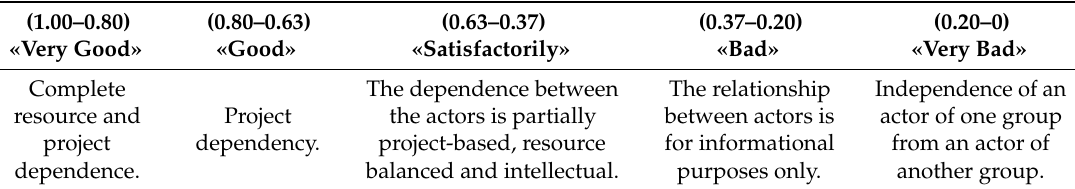
Table 5. Harrington desirability scale.